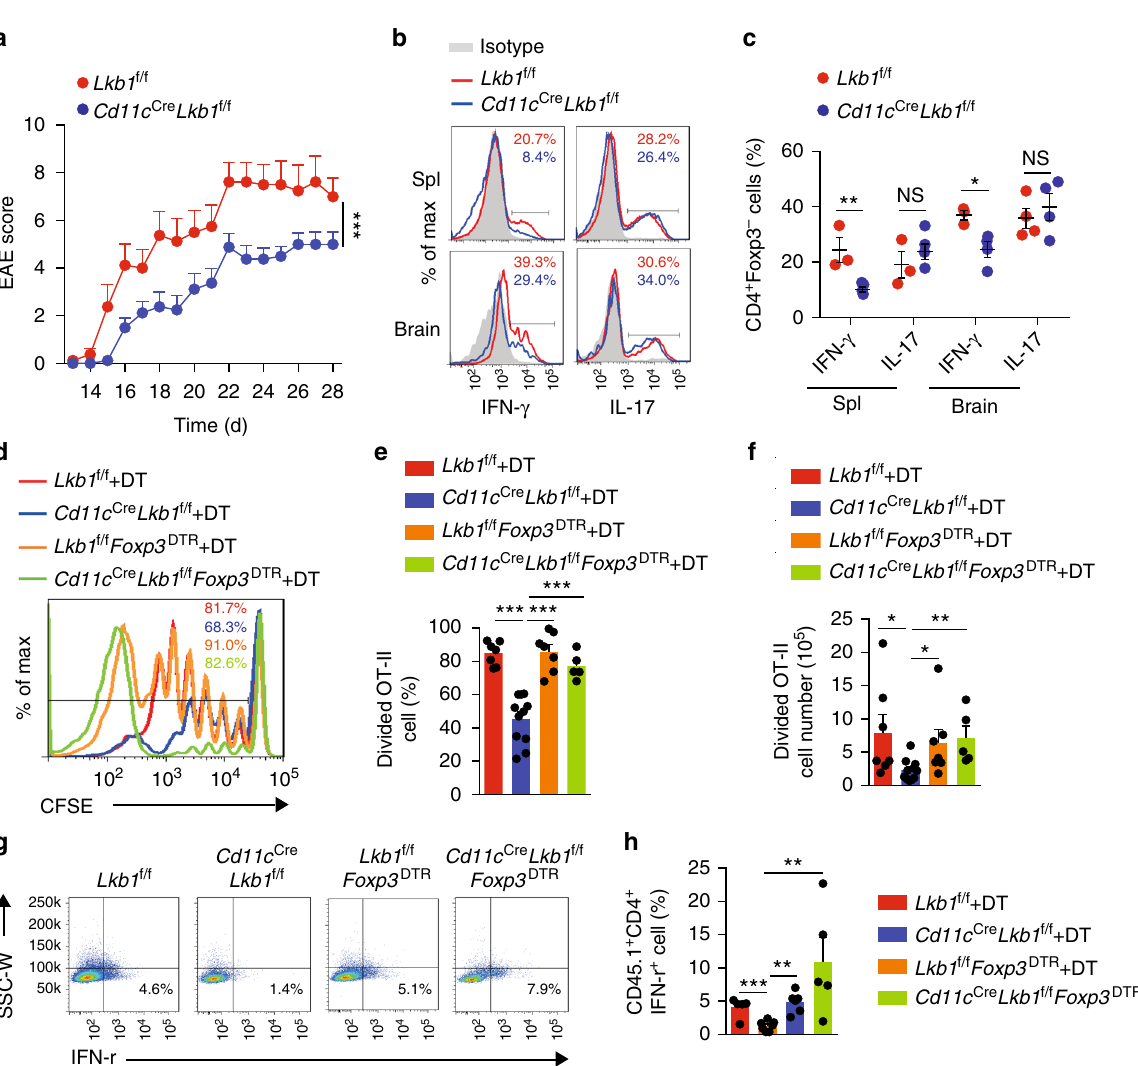
f AMPK α 2 f/f mice (Supplementary Fig. 6a-d), suggesting that Lkb1 function in DCs is independent of AMPK activation.